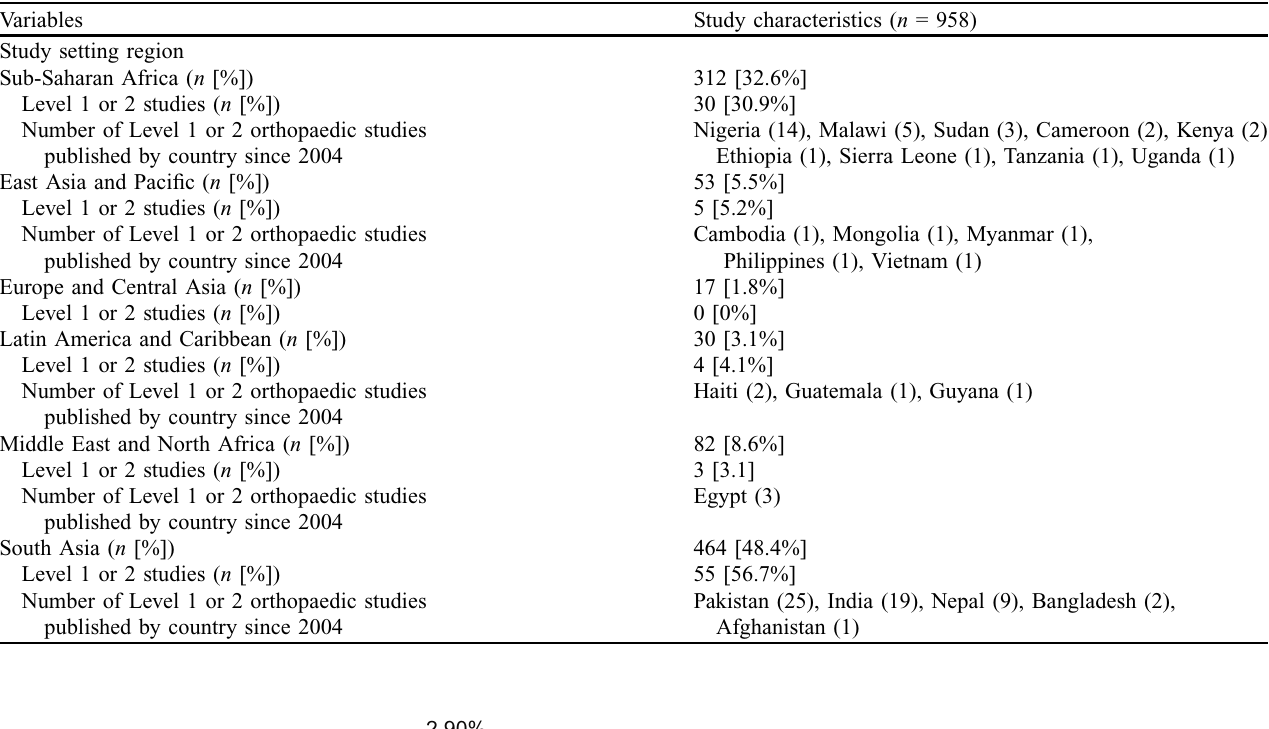
Table 3. Study setting region, Level 1 and 2 studies by region and countries that have published Level 1 and 2 studies.